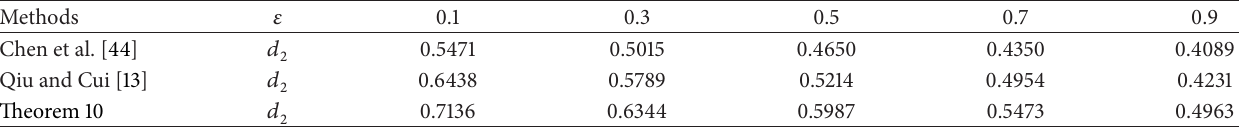
Table 7: Maximum upper bound of 𝑑 2 with different 𝜀 and parameter 𝜇 = 0.9